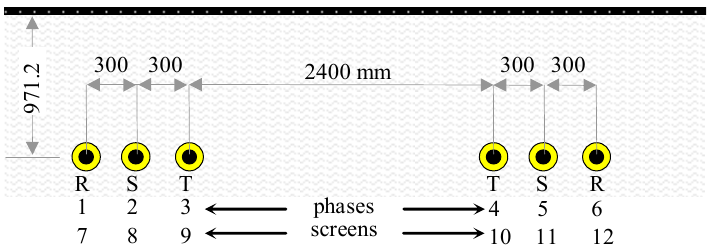
Figure 9. Double-circuit UGC (CB with PTs) in electrical